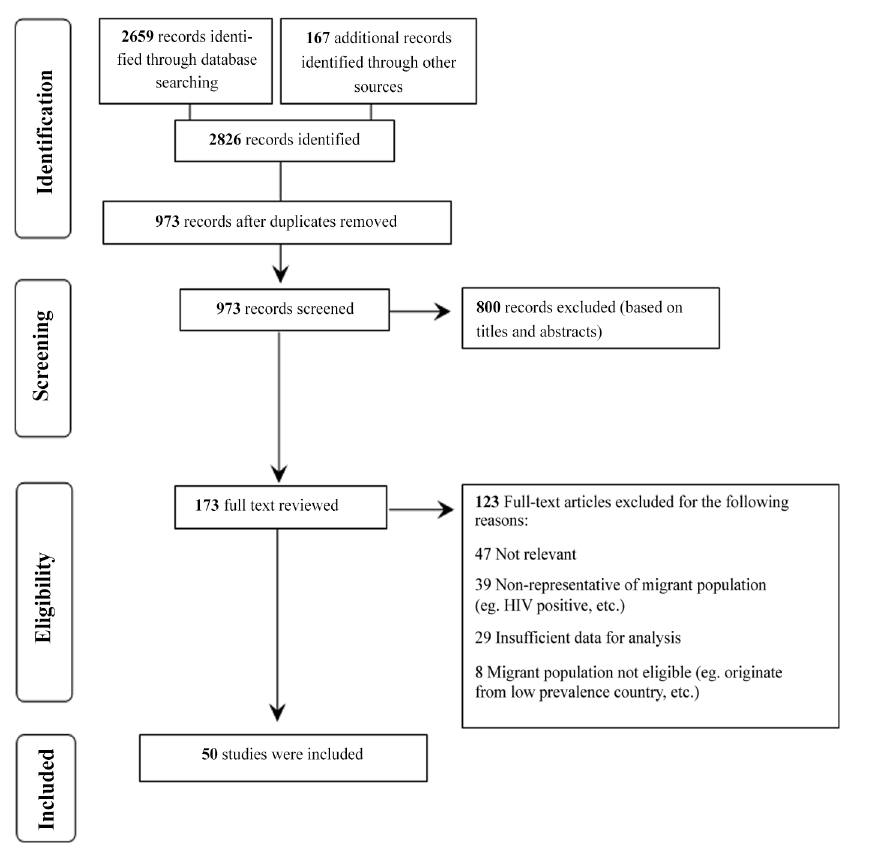
Fig 1. Flowchart of the identification, screening, and inclusion/exclusion of